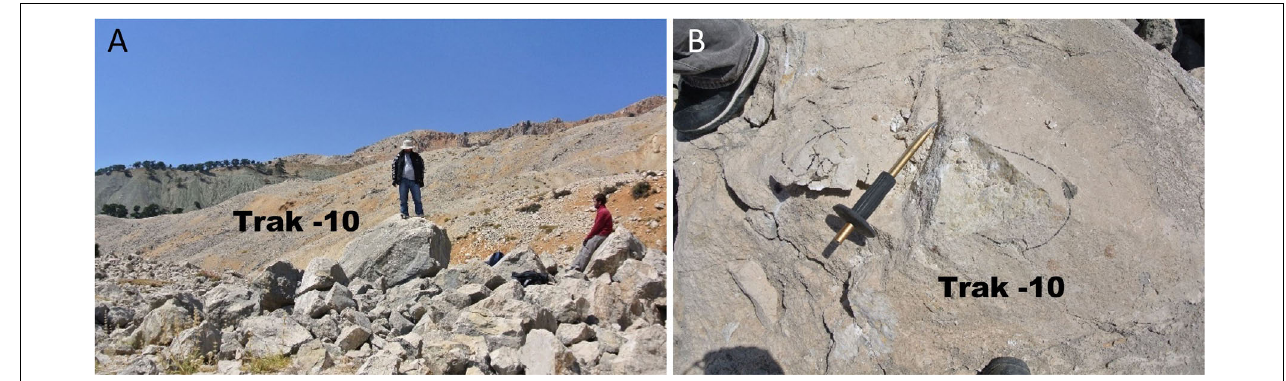
FIGURE 5 | (A) Picture of boulder TRAK-10. (B) Close-up view of sampled top boulder surface of TRAK-10.